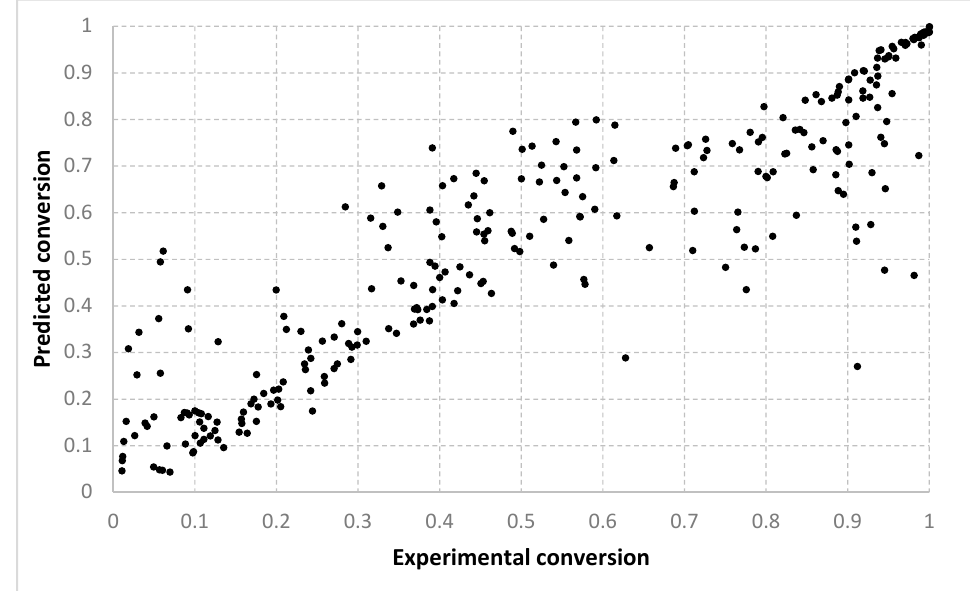
Figure 6. Predicted conversion with the RADIAN algorithm versus experimental conversion, setting 1, with data split into 10% for training and 90% for testing.